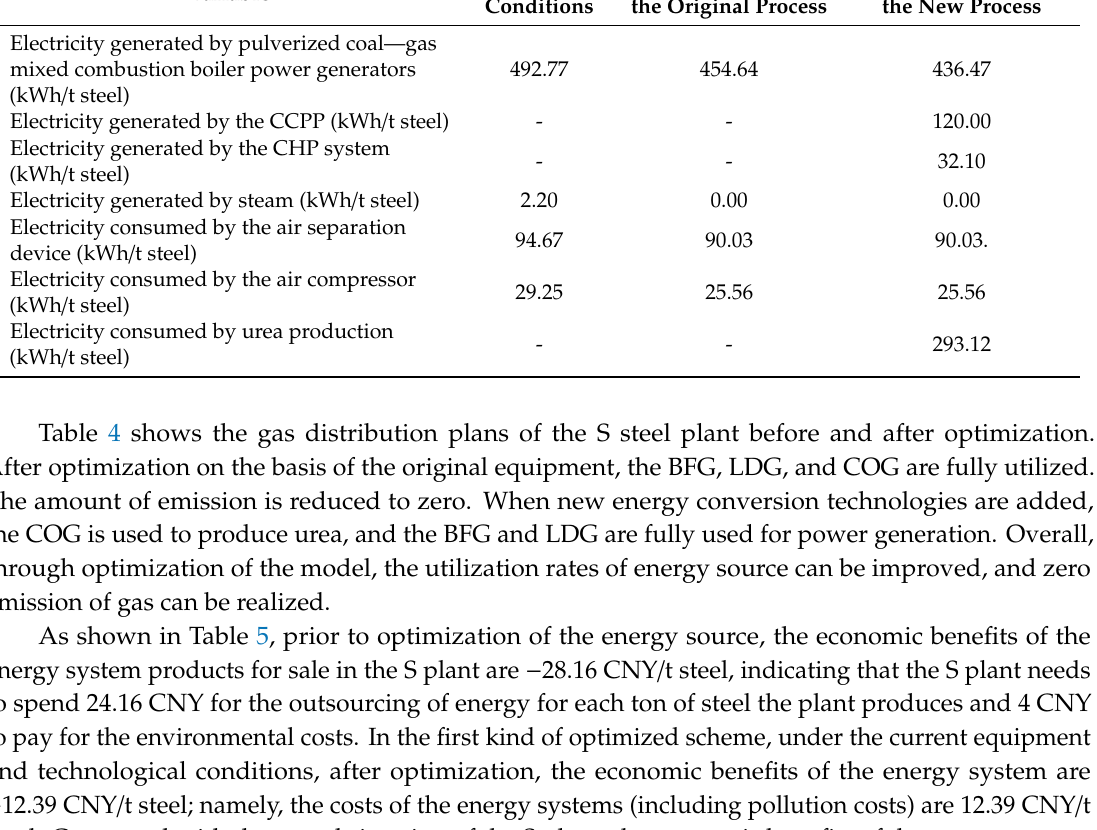
Table 3. Comparison between the model optimization results and practical conditions of electric power production.